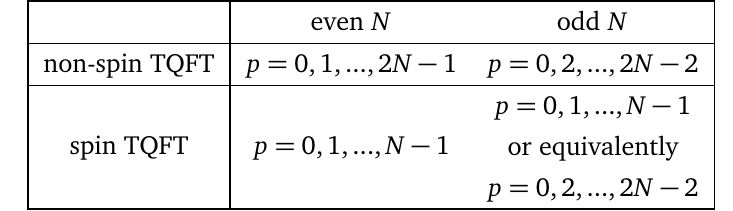
Table 1: The allowed labels p for (cid:90) one-form symmetry up to the redundancy in N redefining the generators of the symmetries. A (cid:90) one-form symmetry of parameter N p is generated by a line a of spin h [ a ] = p mod 1. For a non-spin TQFT, we need 2 N pN ∈ 2 (cid:90) , and p ∼ p + 2 N . For a spin TQFT, we can use pN ∈ (cid:90) and p ∼ p + N . Alternatively, we can say that in the spin case we keep the condition pN ∈ 2 (cid:90) and add the identification p ∼ p + N only for even N . even N odd N non-spin TQFT p = 0,1,...,2 N − 1 p = 0,2,...,2 N − 2 p = 0,1,..., N − 1 spin TQFT p = 0,1,..., N − 1 or